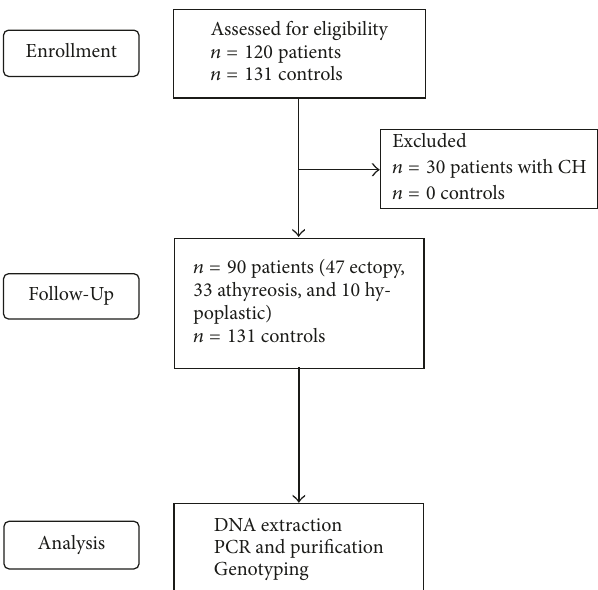
Figure 1: Flowchart diagram of this